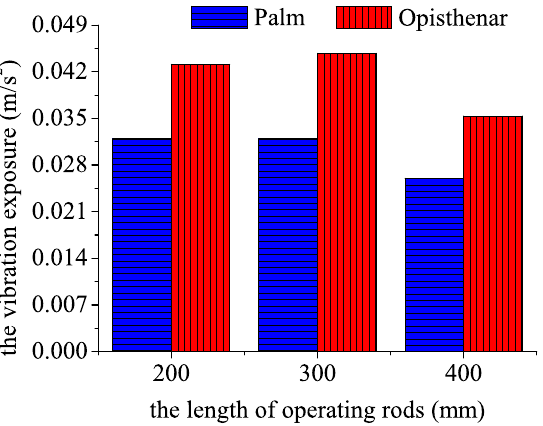
Figure 3. Comparison of the vibration exposure generated by different types of operating